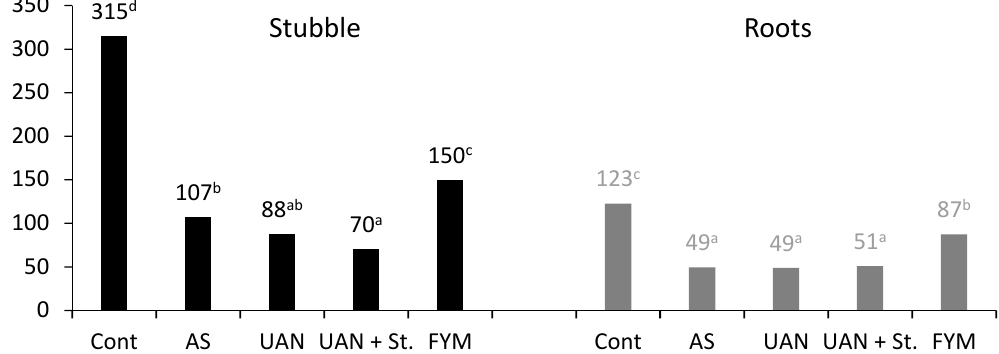
Figure 7. Carbon/nitrogen (C/N) ratio in crop residues of maize; different letters behind the values mean significant differences among investigated treatments (Tukey test; p < 0.05); number of replications per treatment n = 4.